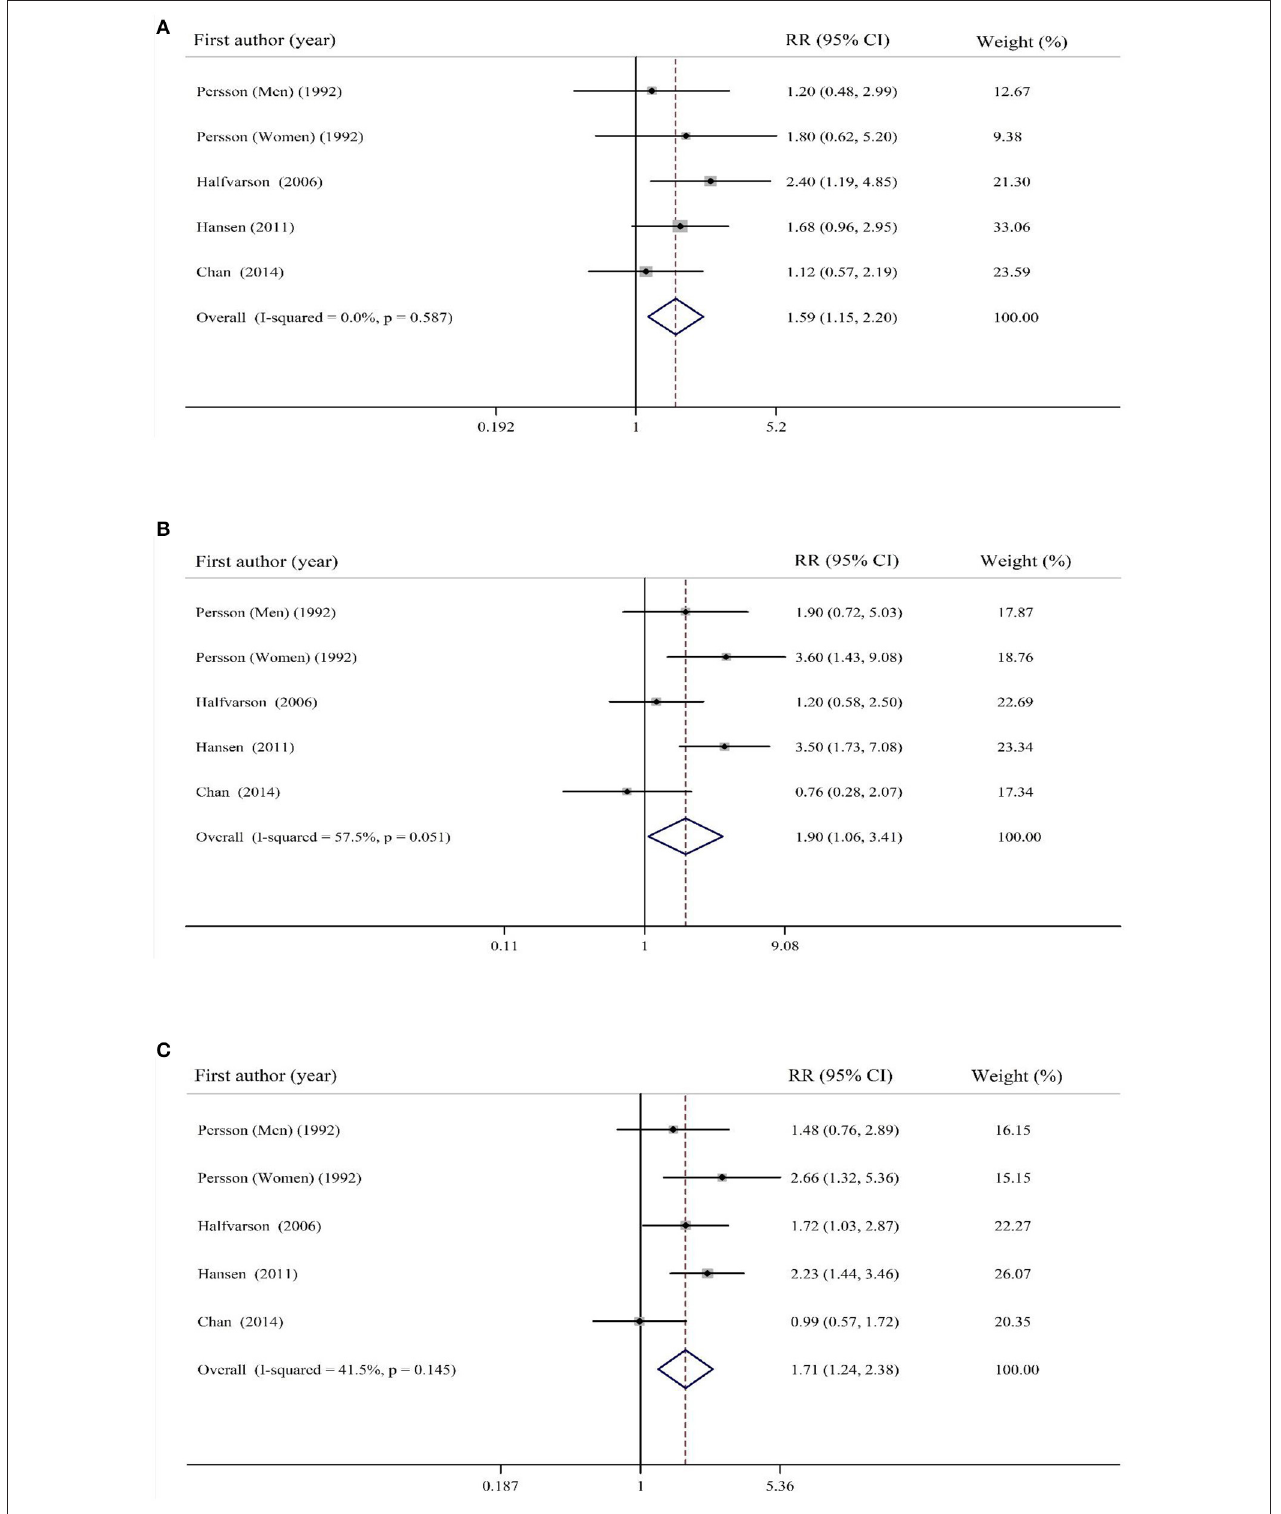
FIGURE 3 | Forest plot for the association of sugar intake with risk of (A) UC, (B) CD, and (C) total IBD. Diamonds represent pooled estimates from random-effects analysis. Horizontal lines represent 95% CIs.